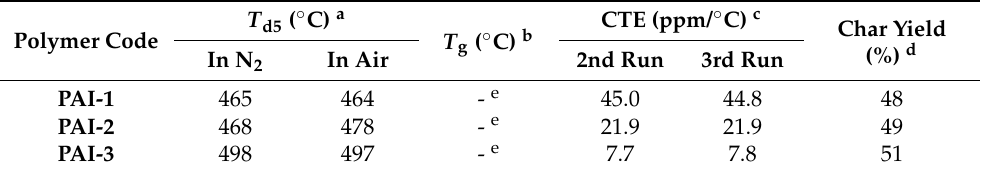
Table 2. Thermal properties of the PAIs.